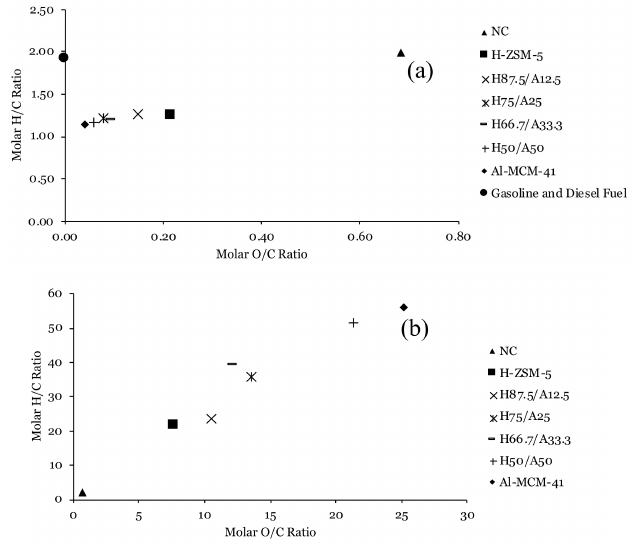
Figure 1. The van Krevelen plot of ( a ) Organic Fraction (OF); ( b ) Aqueous Fraction (AF) produced from pyrolysis of lignocellulose biomass without catalyst (non-catalytic) and with catalyst mixtures. A gasoline and diesel fuel case (54) (in ( a )) is included for